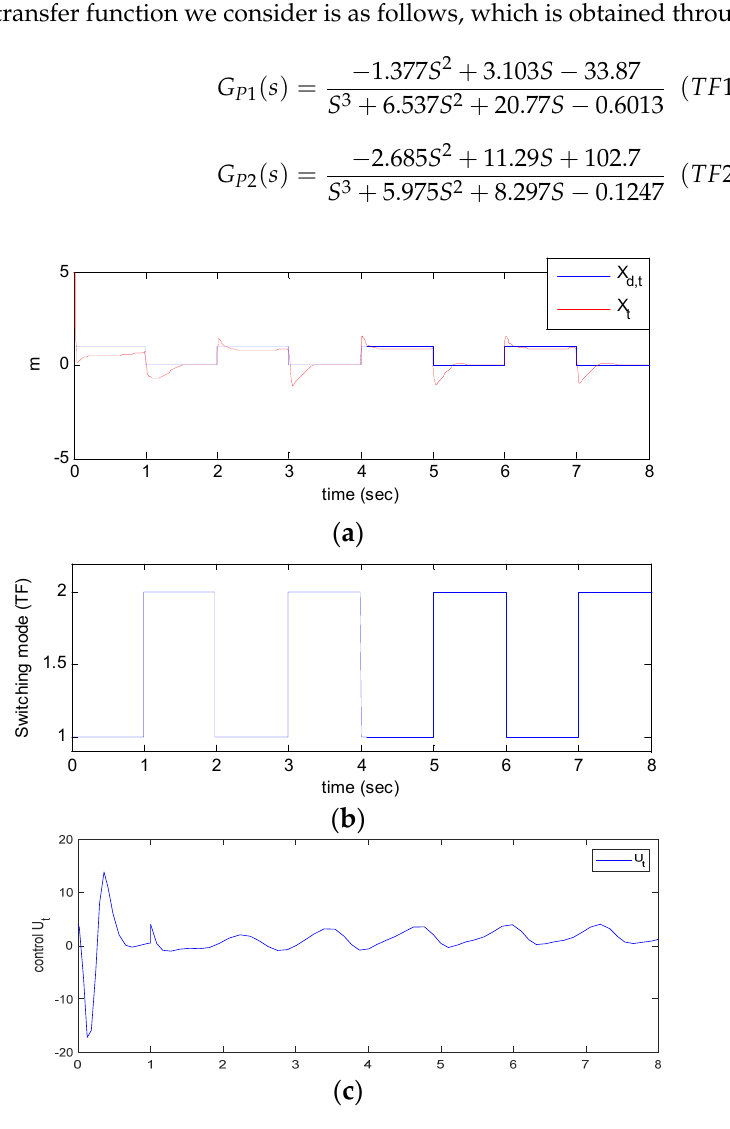
x axis. ( a ) Comparison between the output trajec- Figure 9. Trajectory tracking performance for Figure 9. Trajectory tracking performance for x b axis. ( a ) Comparison between the output trajectory b and reference trajectory; ( b ) switching mode; ( c ) control tory and reference trajectory; ( b ) switching mode; ( c ) control input.